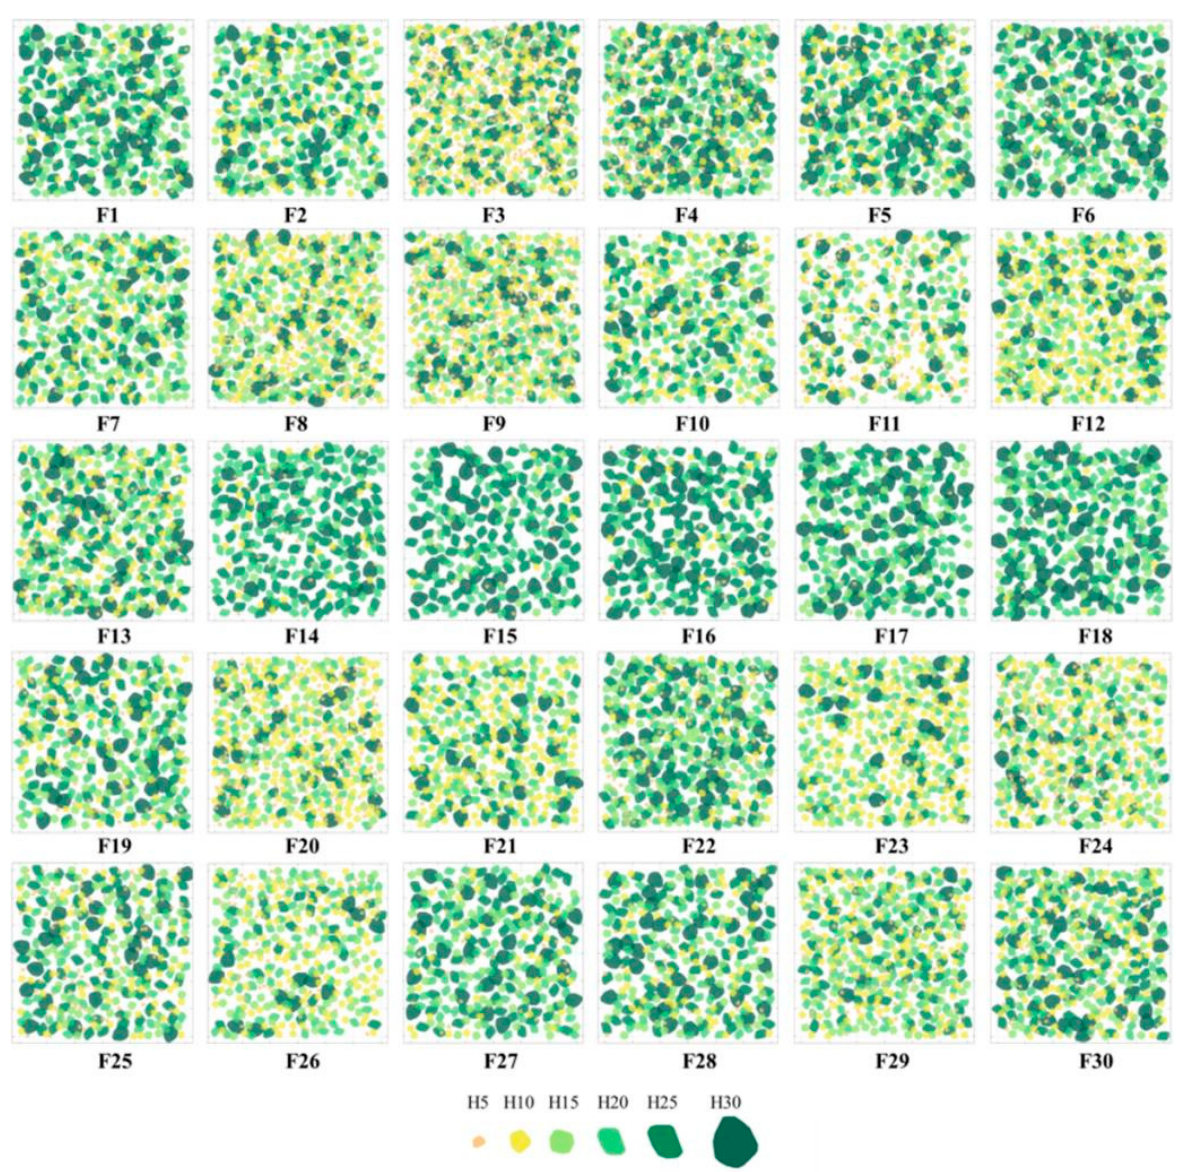
Figure 3. The distribution of trees with different heights in all 30 virtual forest stands (H5, H10, H15, H20, H25, H30 refer to trees of 5, 10, 15, 20, 25, and 30 m heights, respectively).